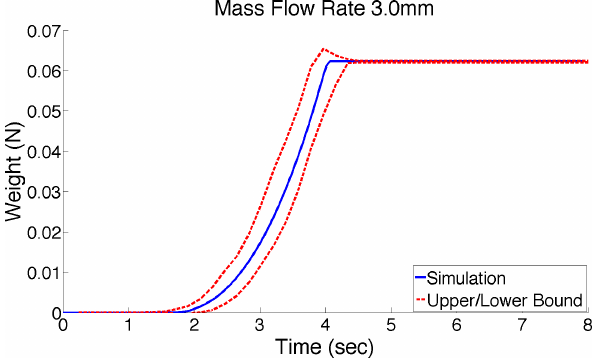
Figure 11. Weight vs. time for a gap size of 3mm. Figure 11 : Weight vs time for a gap size of 3 mm. Figure 11 : Weight vs time for a gap size of 3 mm. Figure 11 : Weight vs time for a gap size of 3 mm. Figure 11 : Weight vs time for a gap size of 3 mm.